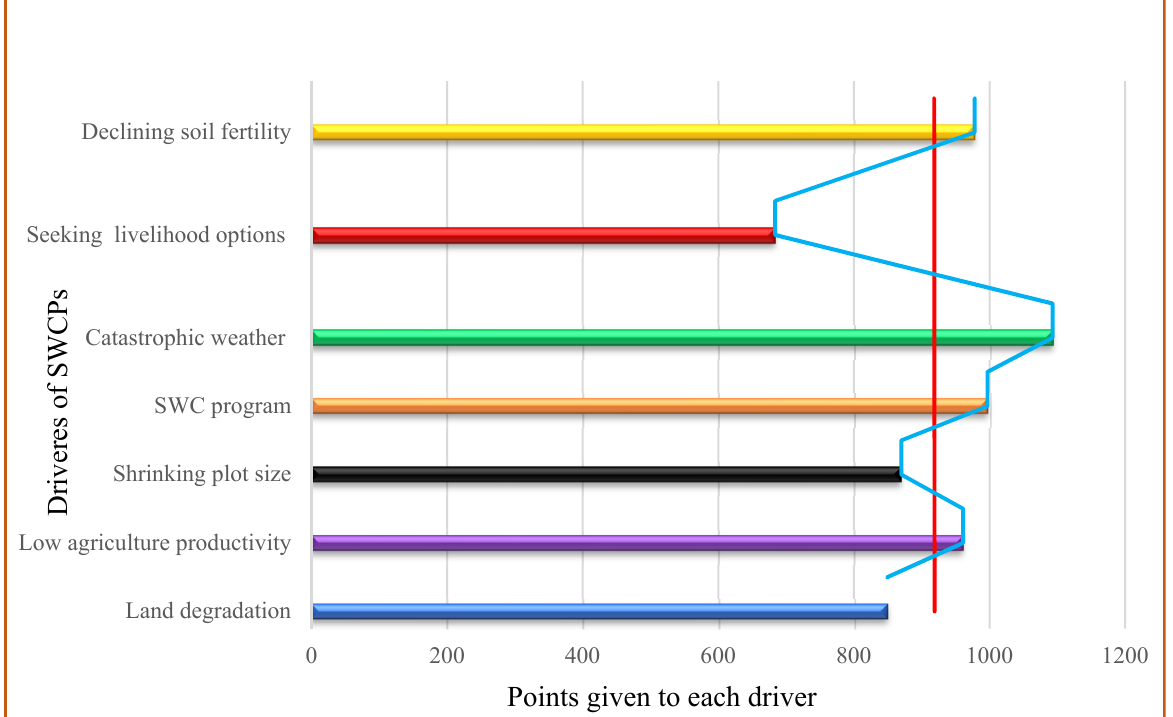
Figure 4. Significant drivers for practising SWCPs.